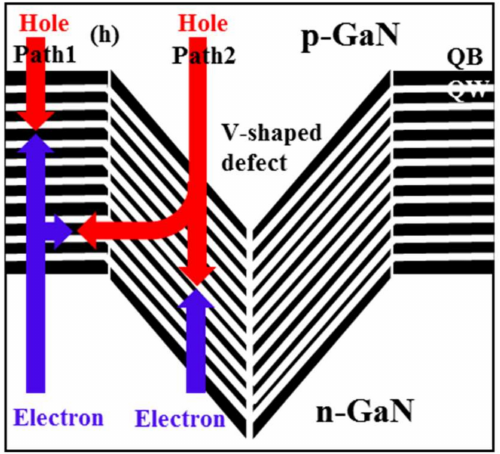
Figure 10. Schematic of the possible current path in large V-defect region and V-defects-free regions. Path 2 acts as a shunt path for carrier injection, while these bottom QWs’ emission